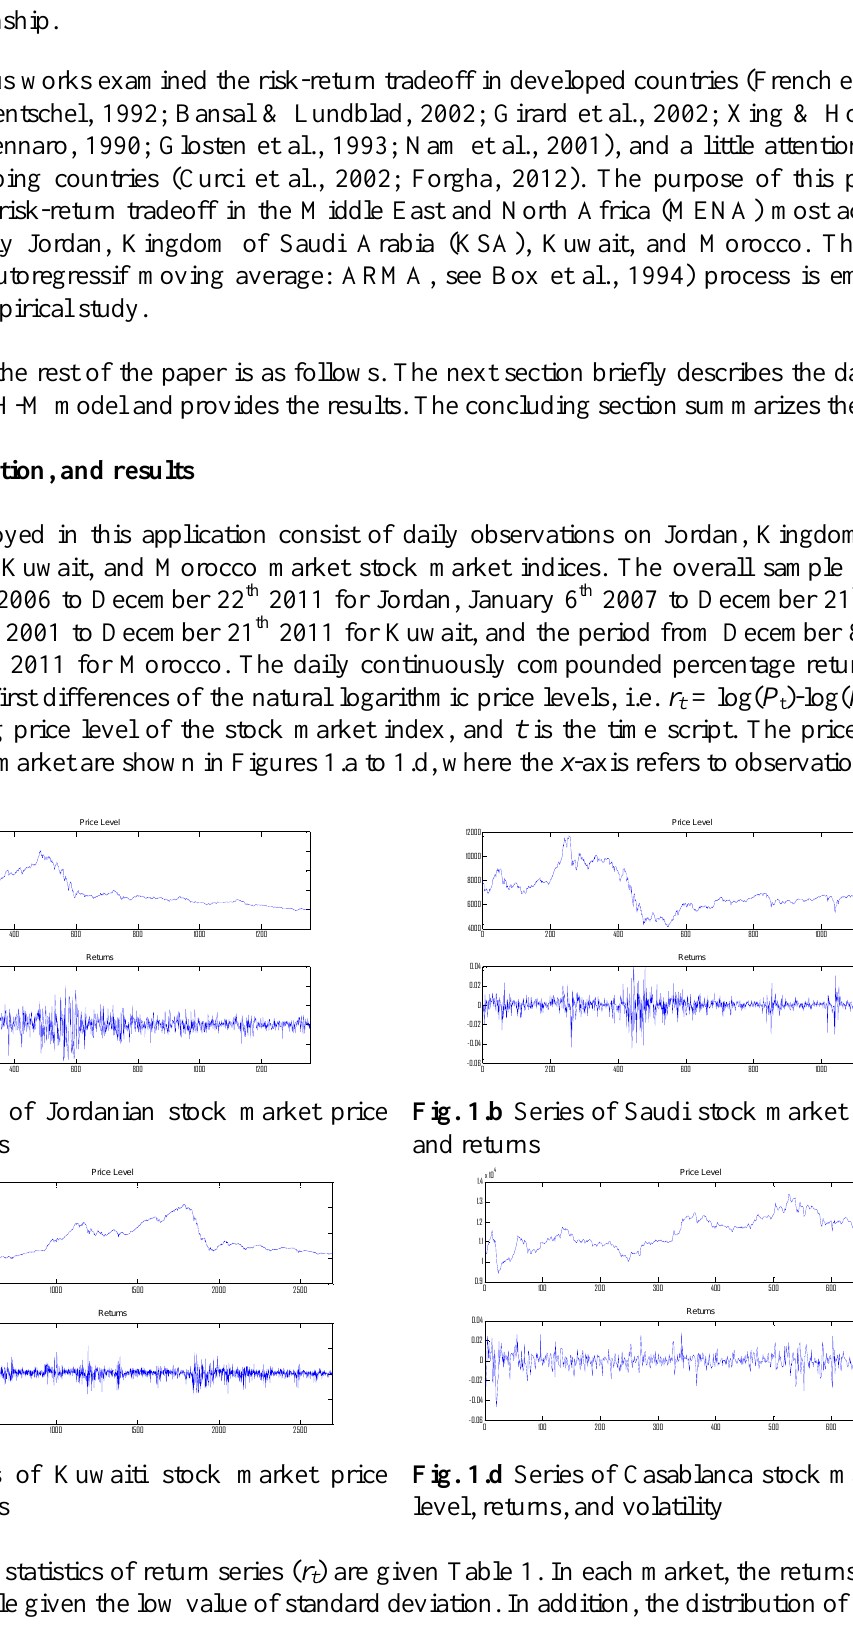
Fig. 1.d Series of Casablanca stock market price level, returns, and